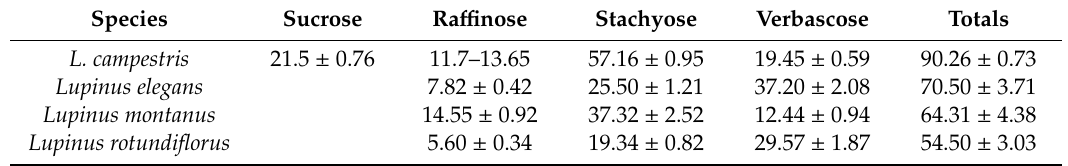
Table 13. Oligosaccharide content in Mexican lupine seeds (mg / g of a dry sample). Species Sucrose Ra ffi nose Stachyose Verbascose